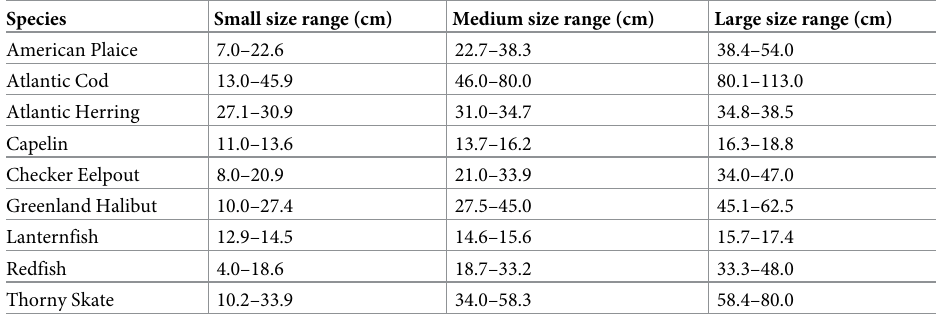
Table 2. Definition of small, medium and large size categories for the most abundant nine fish species. Size cate- gory definitions were consistent across